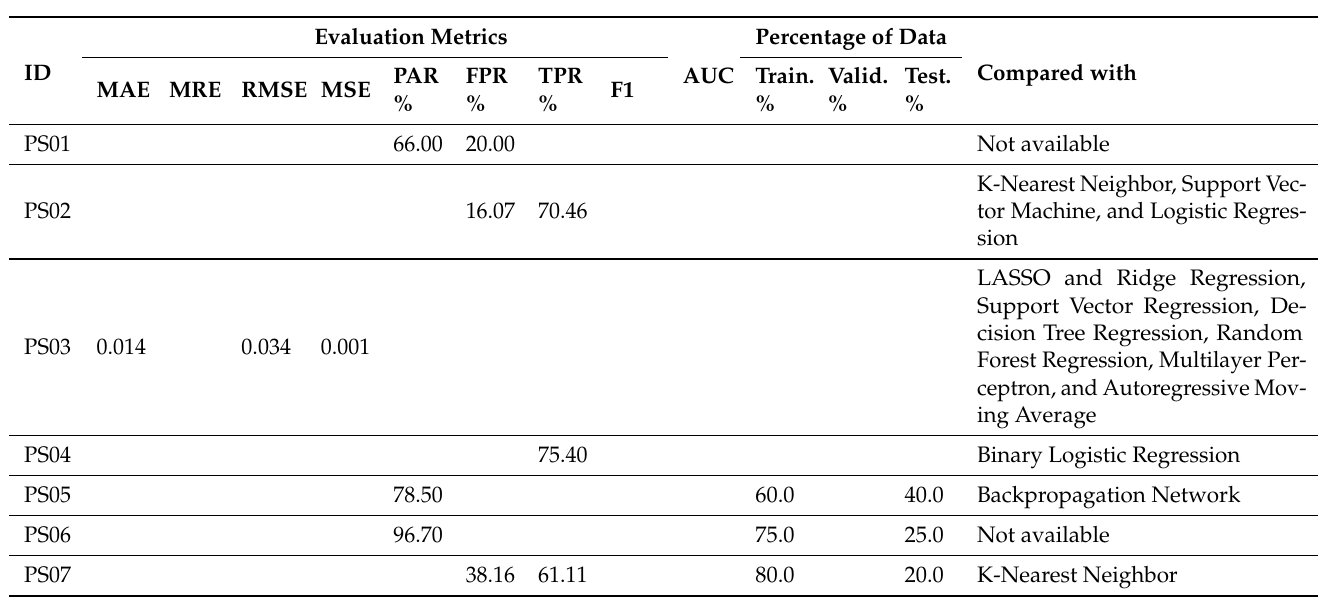
Table 4. Performance of